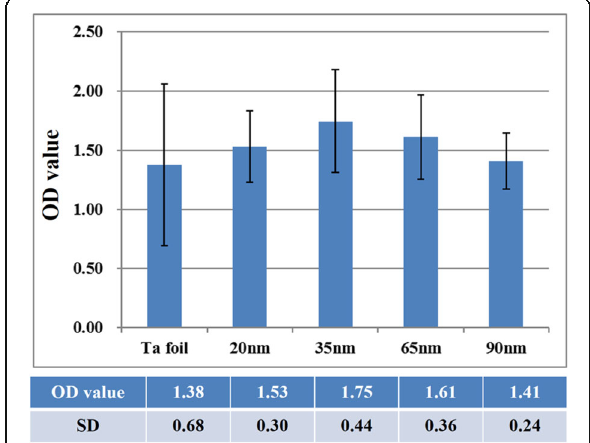
Fig. 8 Optical densities (QD) measured after the culture of human fibroblast cells on the Ta foil and self-organized TaO x nanotubes of different diameters. The OD values with their standard deviations